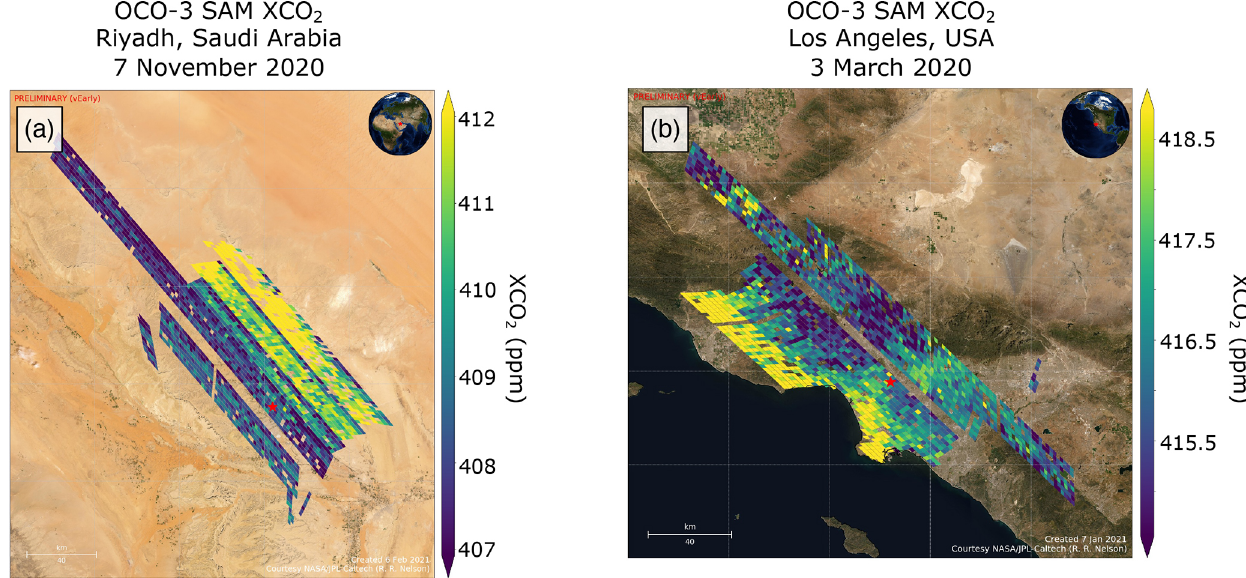
Figure 2. Two examples of swath bias from the raw (no filtering or bias correction) OCO-3 vEarly X CO Saudi Arabia, and (b) Los Angeles,